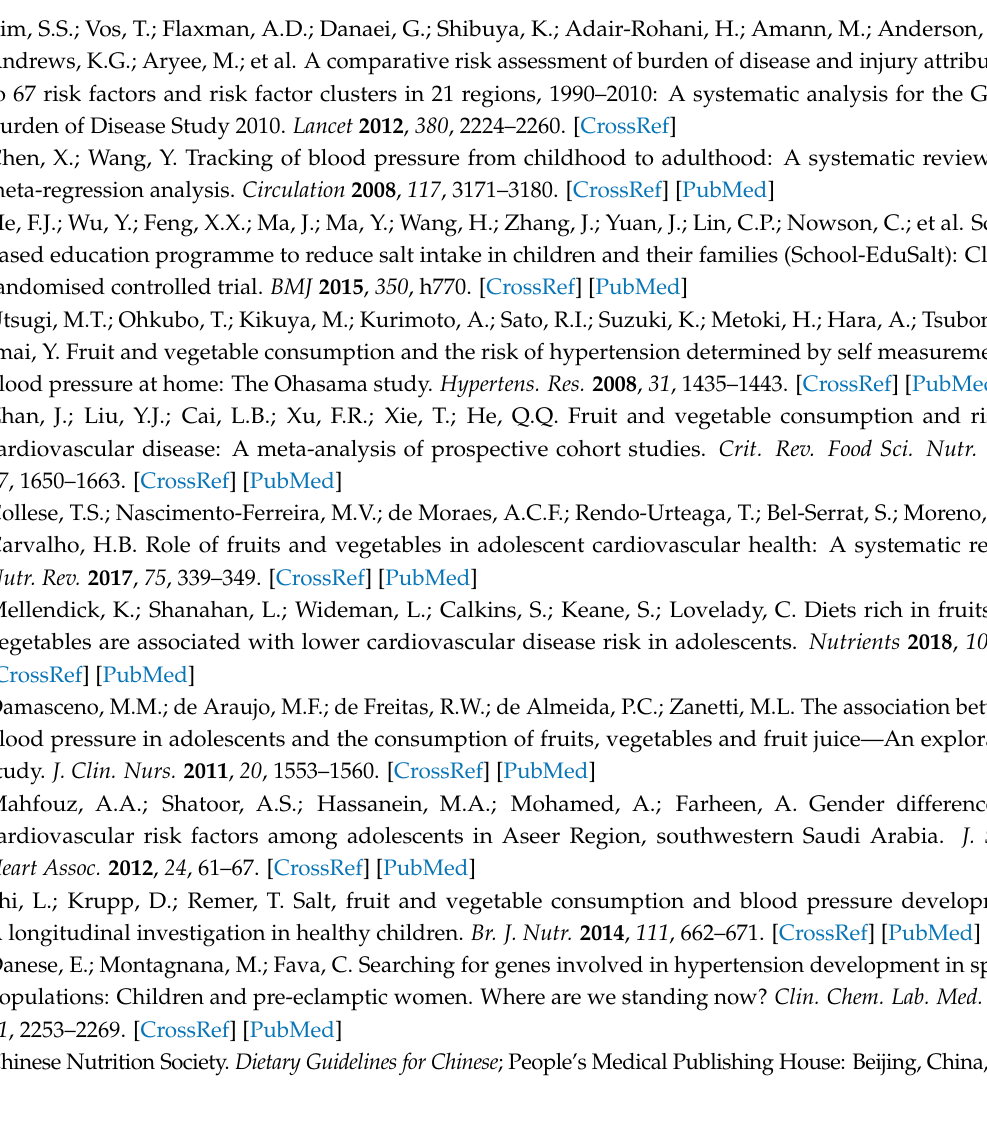
Figure S1: The size of one serving of fruit or vegetable (as the size of a fist of ordinary adult) (The ratio is 1 to 1), Table S1: Body mass index reference for screening overweight and obese individuals in Chinese school-age children (kg/m 2